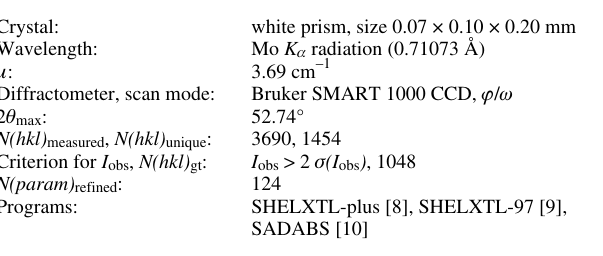
Table 1. Data collection and handling.